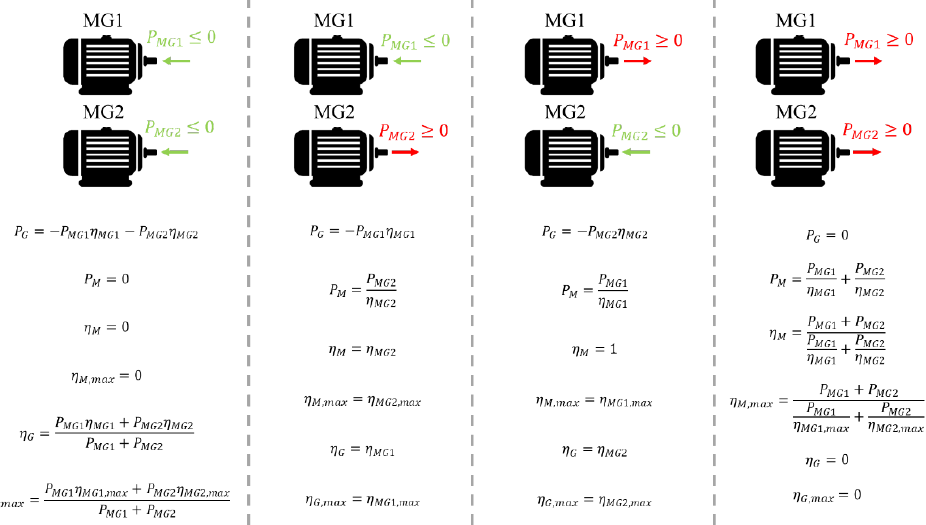
Figure 4. Absorbed and generated electric power P M and P G together with their correspondent efficiencies η G and η M